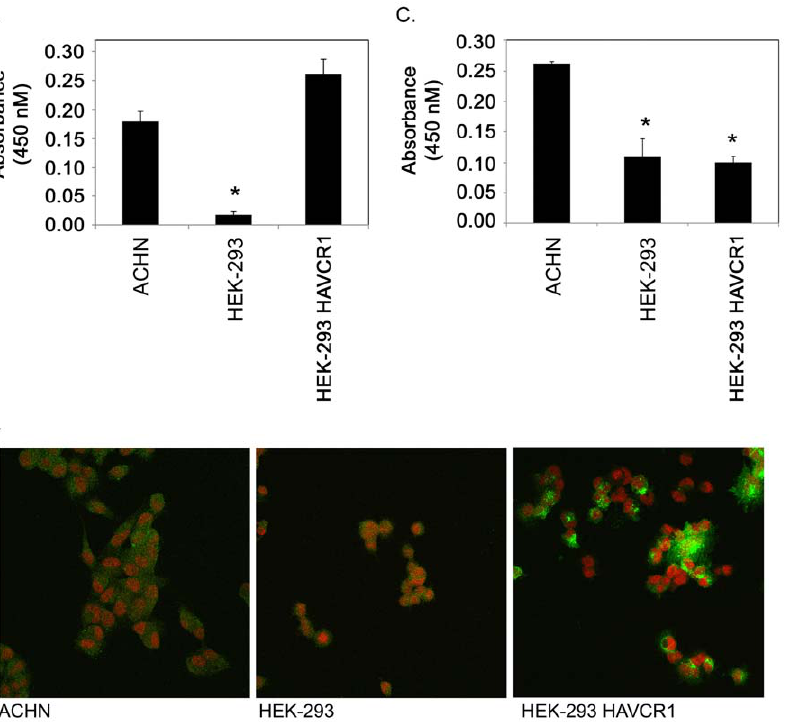
Figure 7. HAVCR1 expression in transfected HEK-293 cells. A . Expression of HAVCR1 in ACHN, HEK-293, and HEK-293 cells transfected with plasmid DNA expressing HAVCR1a from ACHN cells was detected by a cell-surface ELISA [43]. Representative results are presented as the mean and standard deviation of triplicate samples. The asterisk denotes results that are significantly less than the signal from toxin-sensitive ACHN cells (p , 0.05, ANOVA followed by Dunnett’s post hoc test). B . Expression of HAVCR1 on ACHN, HEK-293, and HEK-293 cells transfected with plasmid DNA expressing HAVCR1a from ACHN cells was detected by fluorescence microscopy as described in Materials and Methods. Green: HAVCR1; red: 7-AAD. C . Binding of e -toxin to ACHN, HEK-293, and HEK-293 cells transfected with plasmid DNA expressing HAVCR1a from ACHN cells was detected by a cell-surface ELISA. Representative results are presented as the mean and standard deviation of triplicate samples. The asterisks denote results that are significantly less than the signal from toxin-sensitive ACHN cells (p , 0.05, ANOVA followed by Dunnett’s post hoc test).